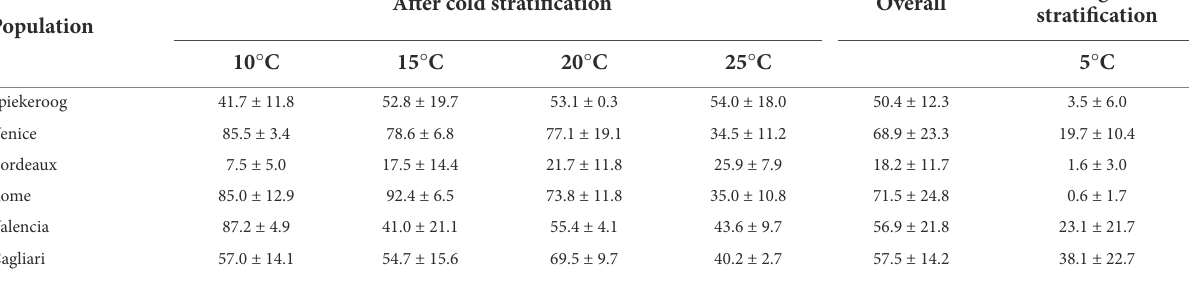
TABLE 1 Germination percentage (mean ± SD) of cold-stratified seeds (3 months at 5 ° C) of Thinopyrum junceum at the tested temperatures, and during cold stratification. After cold stratification Population